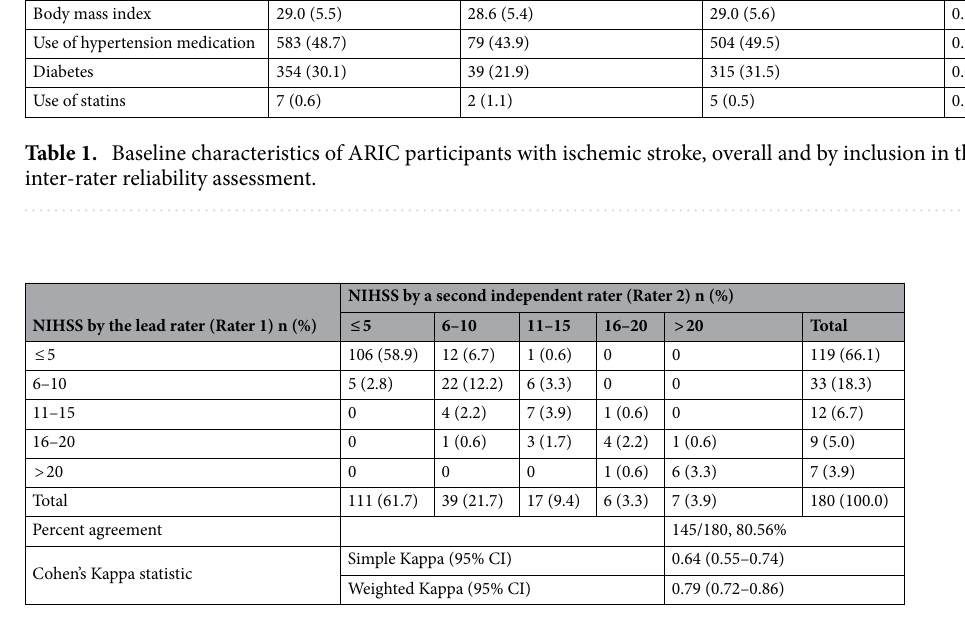
Table 2. Distribution of NIHSS category by rater and inter-rater agreement measures, N =